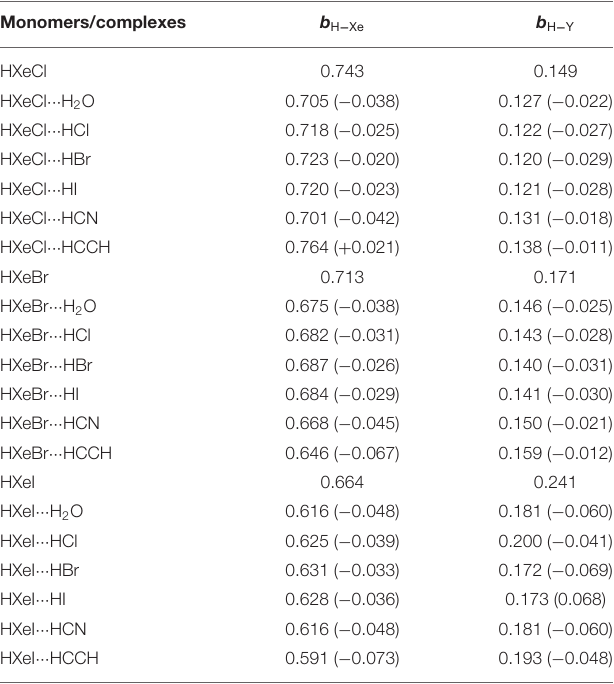
TABLE 3 | The H-Xe bond orders: b H − Xe (electron-sharing), b H − Xe (dative), and the total [ b H − Xe (electron-sharing) + b H − Xe (dative)], for the monomer and their hydrogen-bonded complex, with the changes shown in